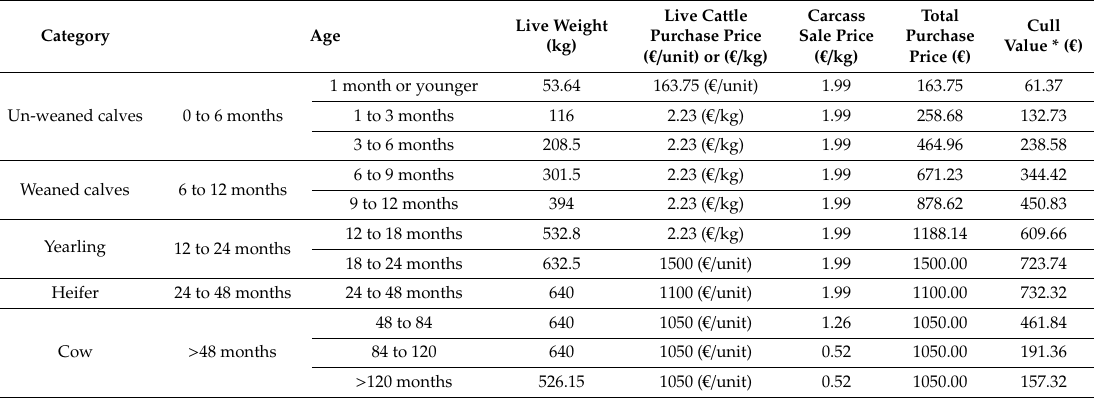
Table 1. Category, age, weight, live purchase price and carcass value. Source: Own preparation based on data from the Talavera de la Reina Market as of 31 December